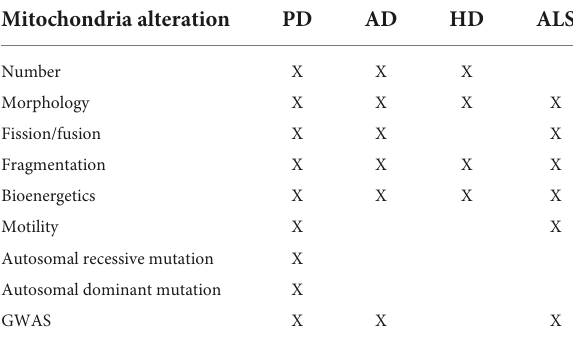
TABLE 1 Summary of mitochondrial phenotype and mitophagy genes associated with neurodegenerative diseases. Mitochondria